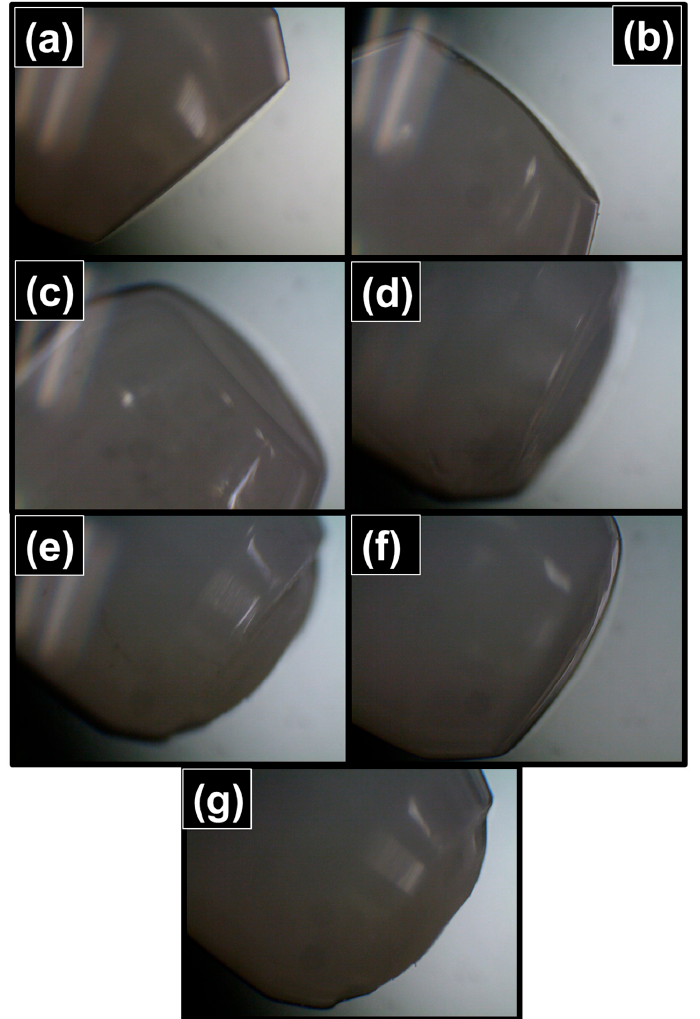
Figure 4. Microscopic view of ( a ) uncoated SMF, ( b ) PMMA_SPFPI, ( c ) PC_SPFPI, ( d ) PMMA_PC-S1, ( e ) PMMA_PC_S2, ( f ) PC_PMMA_S1, and ( g ) PC_PMMA_S2 DPFPI sensors.